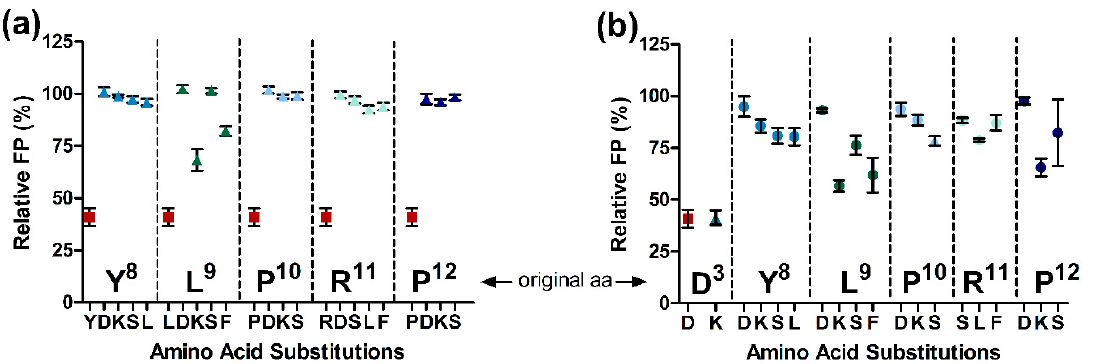
Figure 3. Relative FP using E. coli 70S ribosome and Cf-ARV-1502 competing with ARV-1502 analogs ( ▲ ) ( a ) and [D3K]-ARV-1502 analogs ( ● ) ( b ) substituted at the indicated position of the binding motif YLPRP a concentration of 1.2 µmol/L. The relative FP values of ARV-1502 and [D3K]-ARV-1502 are indicated by ■ and ▲ , respectively.